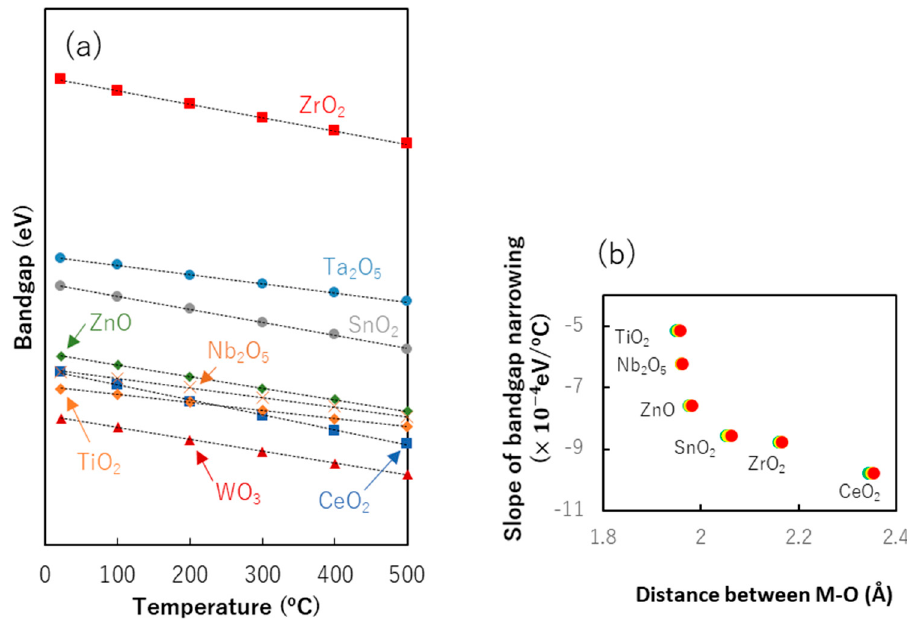
Figure 58. ( a ) Relationship between the bandgap values and temperature for various semiconductors. ( b ) The relationship between the slope obtained in ( a ) and the metal–oxygen (M-O) ion distance. Reprinted from [73] with permission of AIP Publishing.